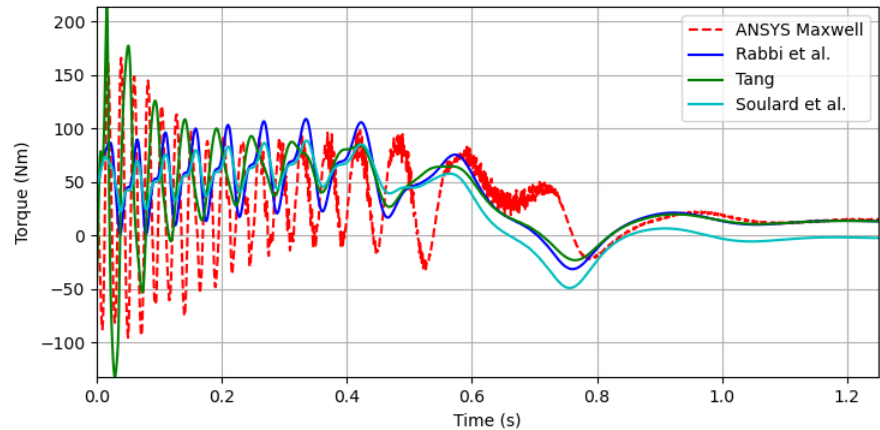
Figure 12. T i for various (Rabbi et al. [8], Tang [17], Soulard et al. [19]) T p